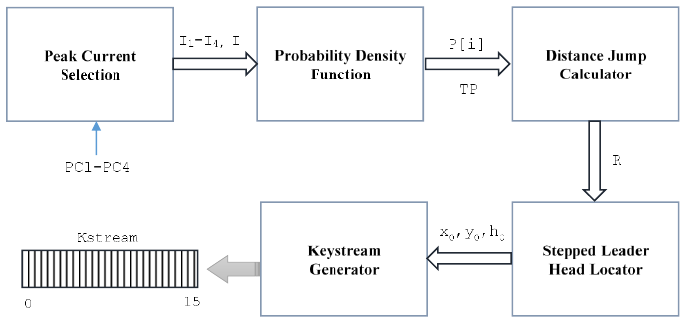
Figure 5. Lightning strike generator for keystream.